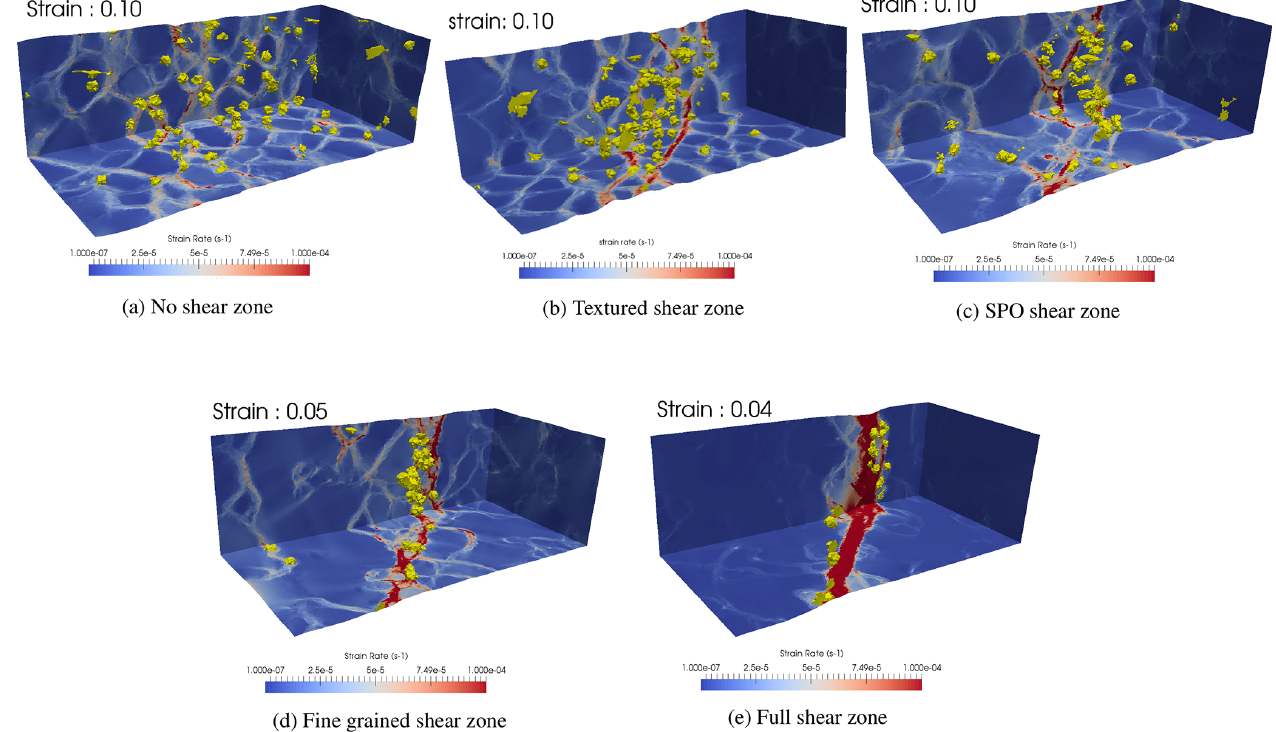
Figure 7. Samples after 10% of macroscopic deformation for no pre-existing (a) , textured (b) , SPO (c) shear zones, after 5% of macroscopic strain for small grain size (d) and after 4% of macroscopic strain for textured plus small grain size shear zone (e) . Colors indicate the strain rate intensity and yellow volumes represent the dynamically recrystallized